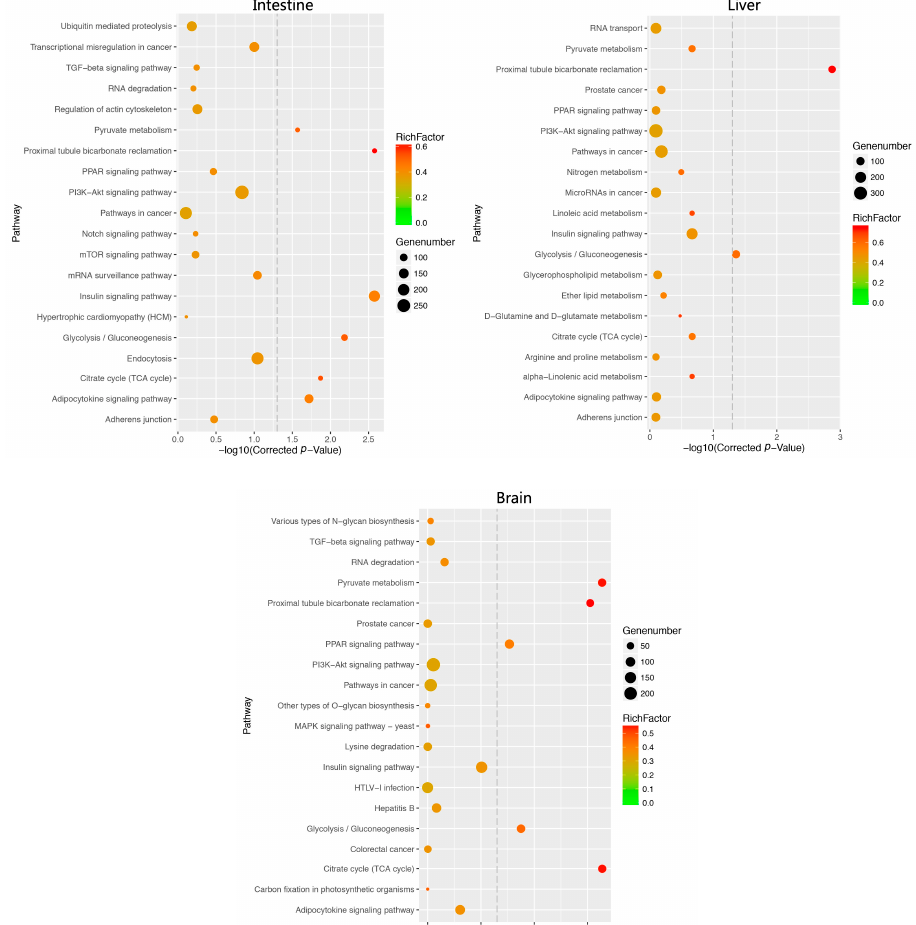
Figure 5. Kyoto Encyclopedia of Genes and Genomes (KEGG) pathway classifications for predicted targets of different expression miRNAs in M.amblycephala .